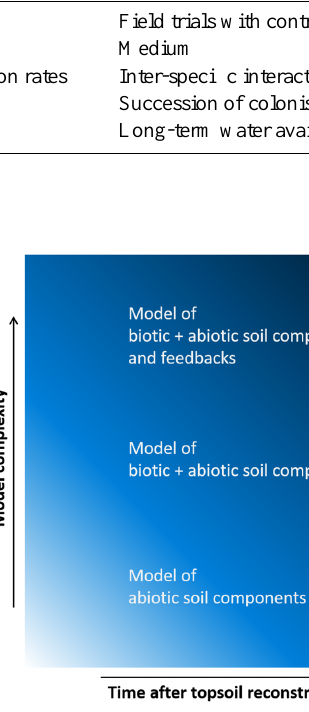
Figure 2. Conceptual scheme of predictive power of soil water models at different levels of complexity. While uncertainty in hy- drological variables such as deep drainage or plant available water is lowest for traditional models that only consider abiotic soil com- ponents, these models may also have low predictive power due to omission of critical macrofauna–soil structure interactions. Integra- tion of biotic components and feedbacks between macrofauna taxa, as well as between macrofauna and soil development, increases model complexity and thereby uncertainty. However, quantification of macrofauna–soil interactions by controlled scientific experiments reduces these uncertainties, thereby increasing the predictive power to a level acceptable to assess the risk of potential failure of post- mining land